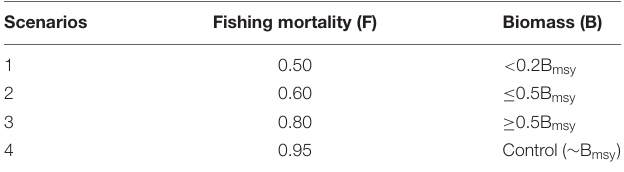
TABLE 3 | Four scenarios using different fishing mortality ratios according to exploitation level of stocks.